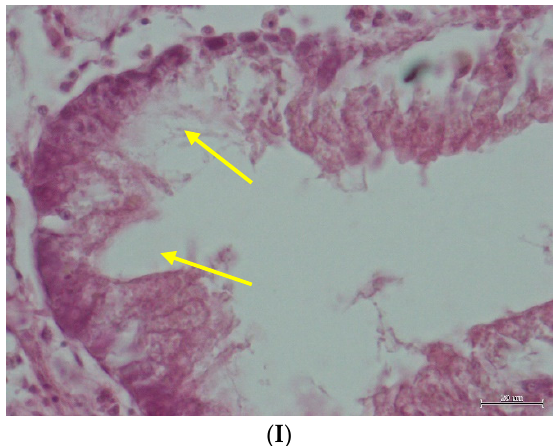
Figure 4. Microscopical lesions observed in oysters (tissue sections are stained with hematoxylin and eosin). ( A , D ) An inflammatory response is observed with the presence of hemocyte in the connective tissue (arrows) ( C. gigas tissue). (Mag = 40 × ; bar = 200 µ m). ( B ) Necrosis of gill tissue (arrow) ( C. angulata tissue) (Mag = 200 × ; bar = 20 µ m). ( C ) Metaplasia of digestive gland (arrows) ( C. angulata tissue). (Mag = 200 × ; bar = 20 µ m). ( E ) Necrosis of gill tissue (arrows) ( C. angulata tissue). (Mag = 100 × ; bar = 100 µ m). ( F ) Metaplasia of digestive gland (arrows) ( C. angulata tissue). (Mag = 100 × ; bar = 100 µ m). ( G ) Trichodina sp. (arrows) in gill tissue ( C. angulata tissue). (Mag = 100 × ; bar = 100 µ m). ( H ) Mytilicola sp. (arrow) in intestine ( C. gigas tissue). (Mag = 40 × ; bar = 200 µ m). ( I ) Loss of epithelium of the digestive gland (arrows) ( C. gigas tissue) (Mag = 200 × ; bar = 20 µ m).